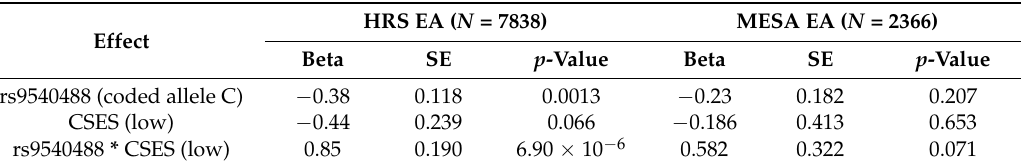
Table 3. Interaction between SNP rs9540488 and childhood socioeconomic status in European Americans (EA) in the Health and Retirement Study (HRS) and the Multi-Ethnic Study of Atherosclerosis